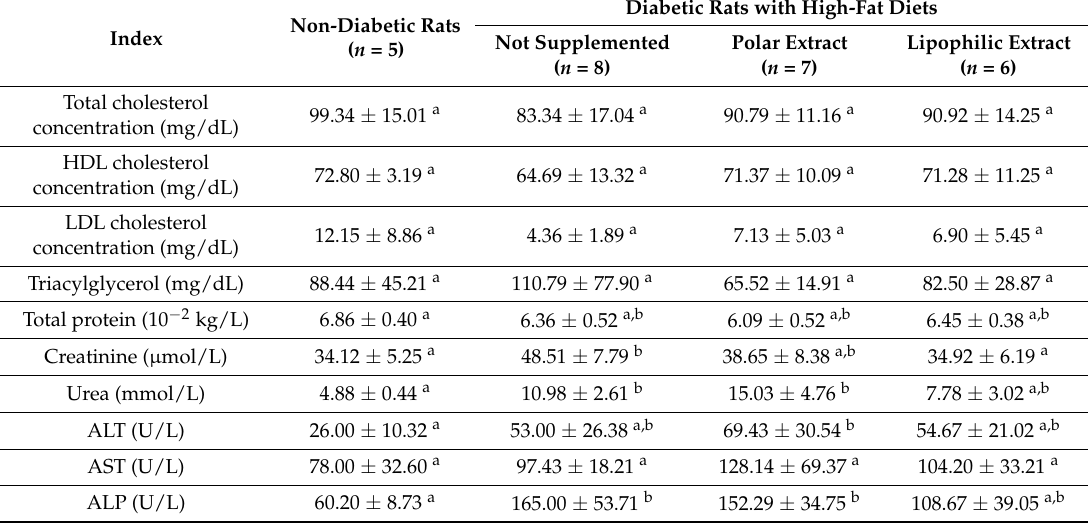
Table 6. Effects of dietary supplementation of elderberry polar and lipophilic extracts on the rats’ sera lipids, inflammatory and toxicity